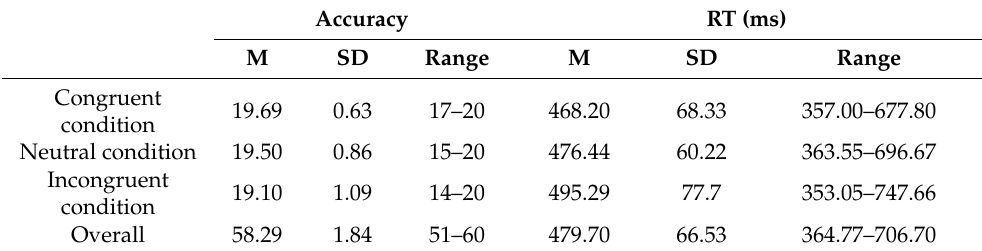
Table 1. Descriptive statistics for Bivalent Shape Task (accuracy and RT).